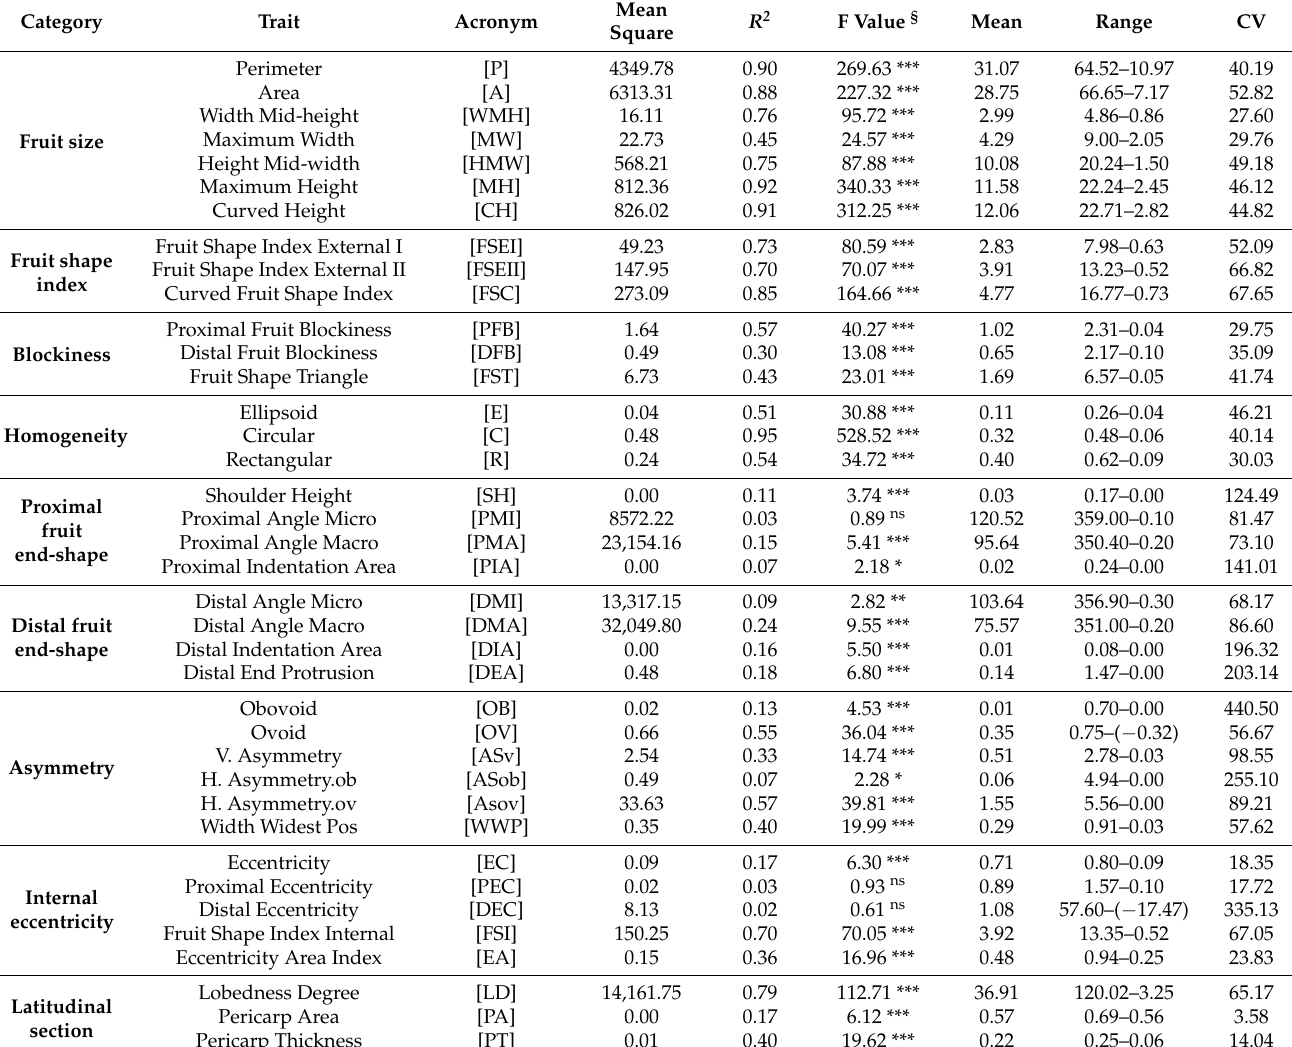
Table 4. Descriptive statistics for chilli pepper fruit parameters assessed through scans and imaging